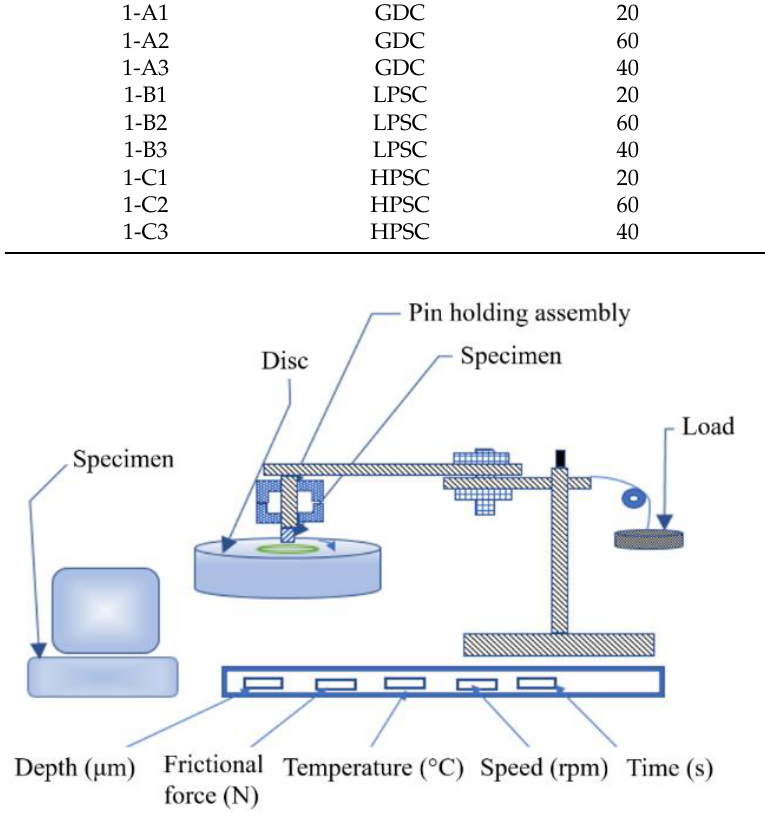
Figure 1. Schematic representation of the pin-on-disc wear testing unit. Table 2. Al-Si alloys wear test input parameters.